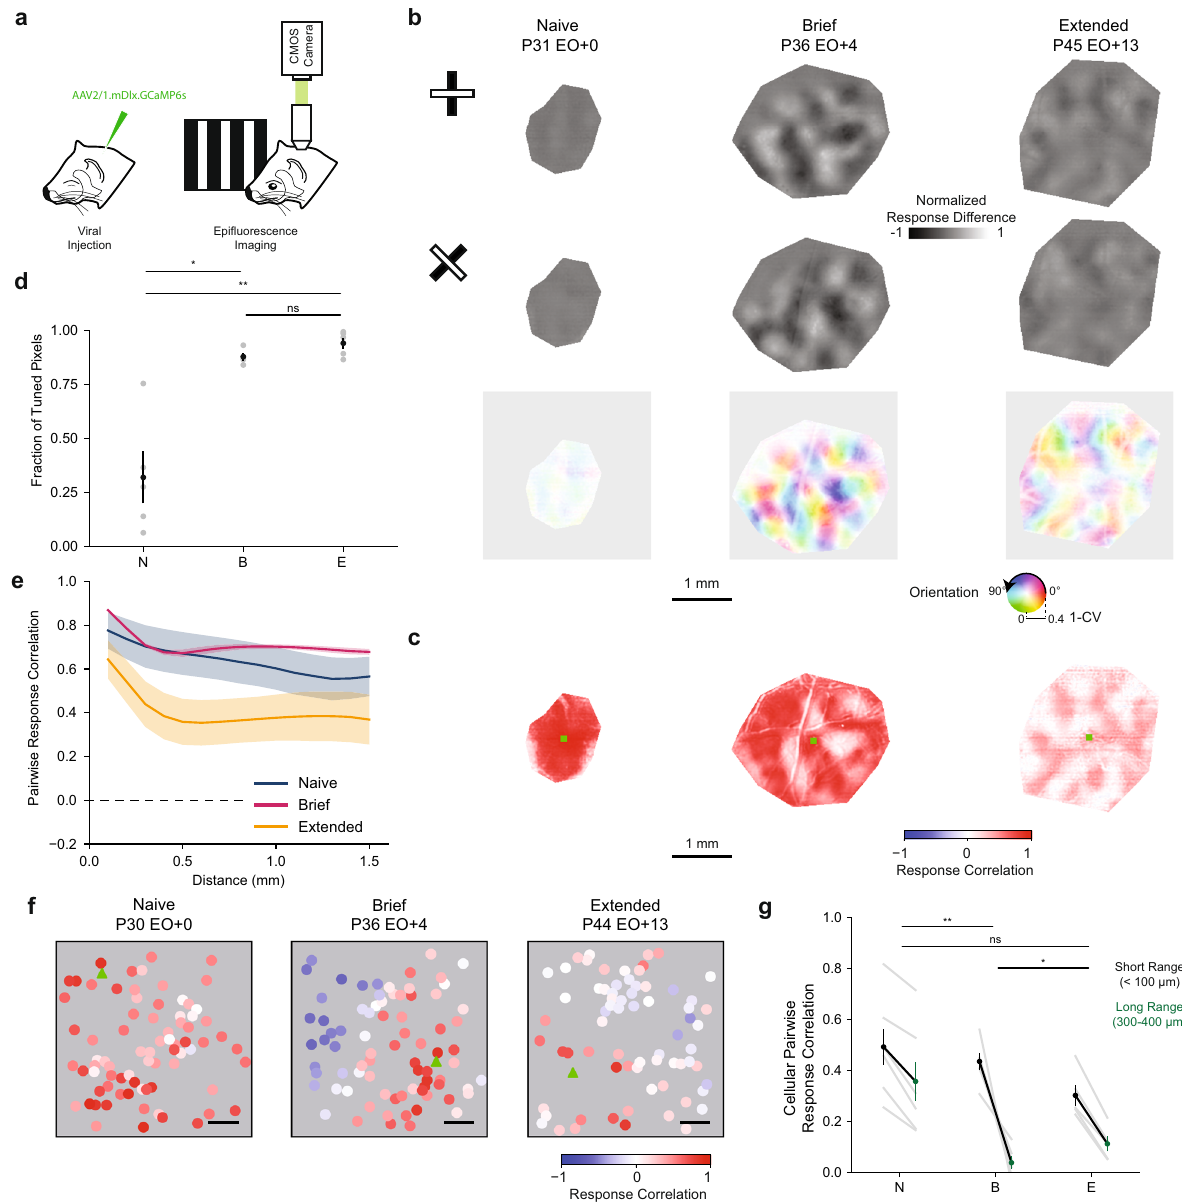
Fig. 3 Clustered responses emerge across development in inhibitory networks. a Wide fi eld epi fl uorescence calcium imaging of GCaMP6s under the mDlx enhancer in ferret visual cortex The ferret images were created by the authors and published in Smith, G.B., Sederberg, A., Elyada, Y.M., Van Hooser, S.D., Kaschube, M., and Fitzpatrick, D., The development of cortical circuits for motion discrimination. Nat. Neurosci . 18, 252 – 261 (2015). b Difference Maps for orthogonal stimuli (top, middle) and orientation preference maps (bottom) for a Naive (left), Brief (Middle), and Extended (right) experience animal. c Example pairwise pixel response correlation maps for a Naive (left), Brief (Middle), and Extended (right) experience animal. Green squares identify the seed positions. d Fraction of pixels that are signi fi cantly orientation tuned compared to shuf fl e (Naive n = 5, Brief n = 4, Extended n = 5; Naive vs. Brief p = 0.0076, Naive vs. Extended p = 0.0050, Brief vs. Extended p = 0.0862). Mean ± SEM, Two-tailed bootstrap test. e Mean distance dependence of pairwise pixel response correlations for Naive (blue, n = 5), Brief (magenta, n = 4), and Extended (gold, n = 5) experience animals. Shaded regions denote the SEM. f Example cellular pairwise correlation patterns for a Naive (left), Brief (middle), and Extended experience (right) animals. The seed cell is denoted by the green triangle and scale bar denotes 100 μ m. g Comparisons of the average short-range (black, <100 µ m) and long-range (green, 300 – 400 µ m) cellular pairwise correlations for Naive (N, p = 0.0003, n = 7), Brief (B, p = 0.0050, n = 6), and Extended (E, p = 0.0004, n = 5) experience animals. Mean ± SEM. * p < 0.05, ** p < 0.005, ns not signi fi cant, Two-tailed Student ’ s paired t test. Source data are provided as a Source Data fi